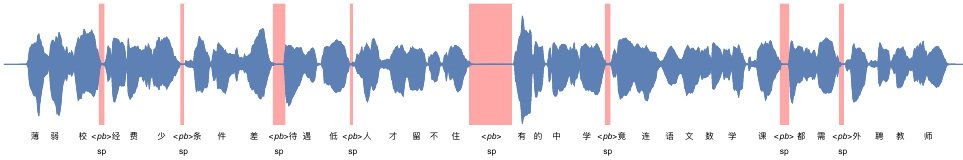
Figure 1. The waveform and aligned transcription for an example sentence, where <pb> means phrase boundary. The pink segments indicate the positions of short pauses (sp) in the waveforms. The English translation of this sentence is “The weak schools with low funding, poor conditions and low salaries are unable to retain talents. Some middle schools even need external teachers for Chinese and mathematics